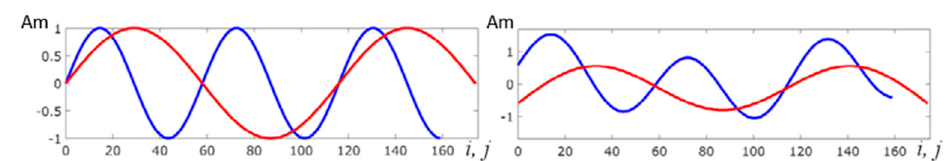
Figure 5. A model experiment to separate factors using the iterative process of consistent refinement of parameter estimates. The red color shows the receiver factor and the blue color shows the source factor.